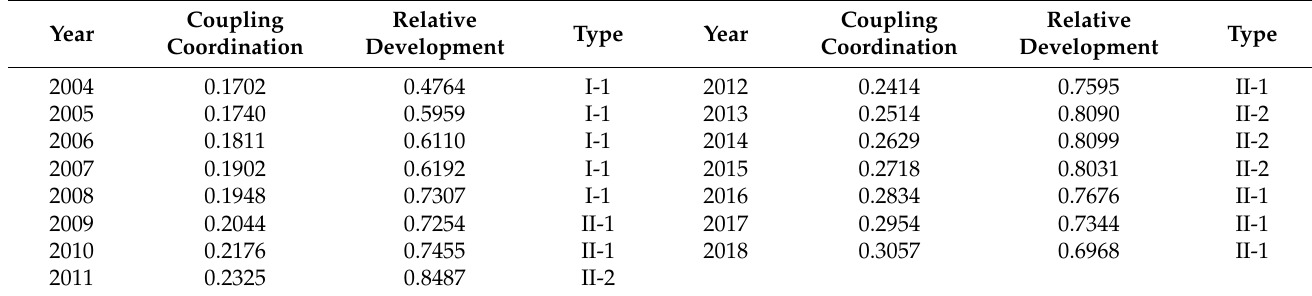
Table 3. Mean value and types of coupling coordination degree between ILU and TID in China’s major tourist cities. Coupling Year Coordination